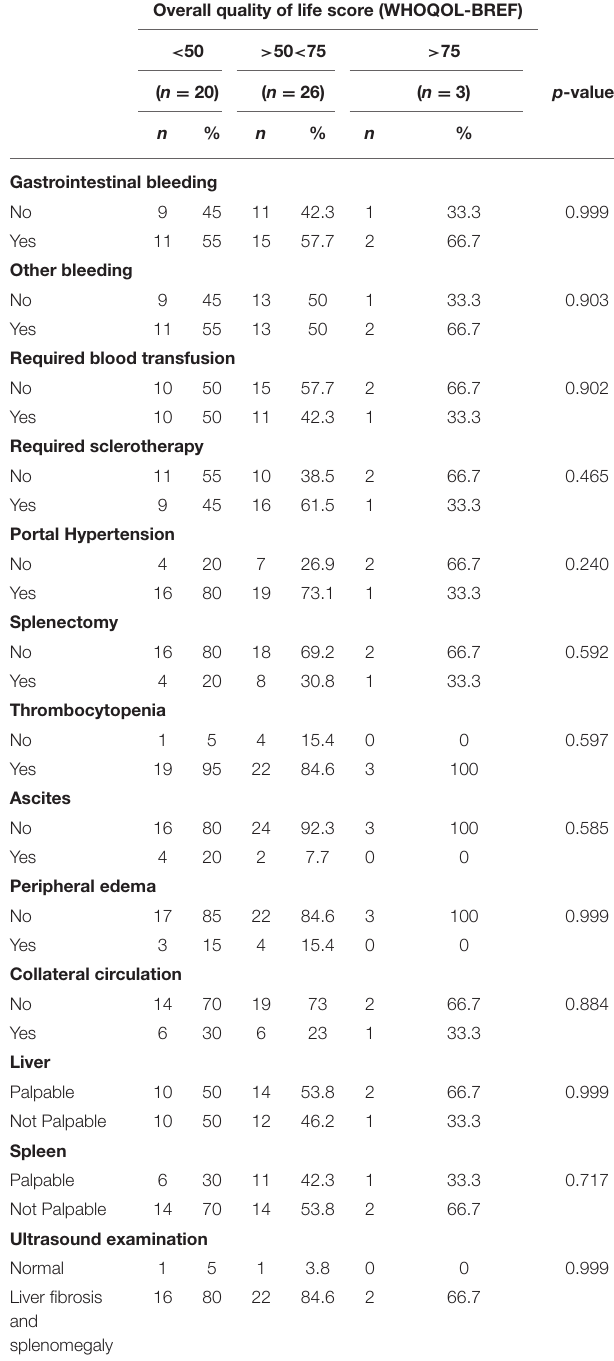
TABLE 4 | Analysis of overall quality of life score and clinical complications of hepatosplenic